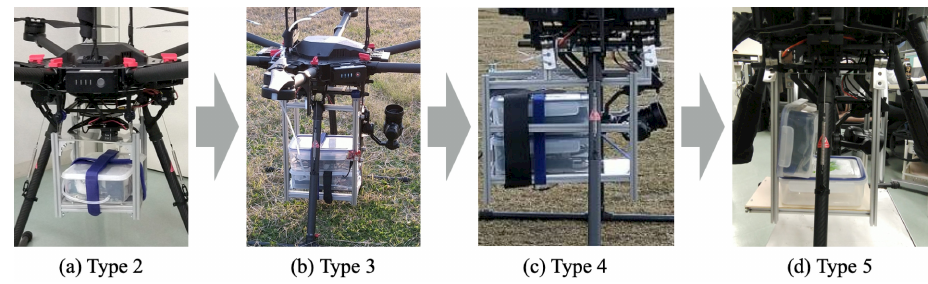
Figure 7. Appearance of Types 2–5 after